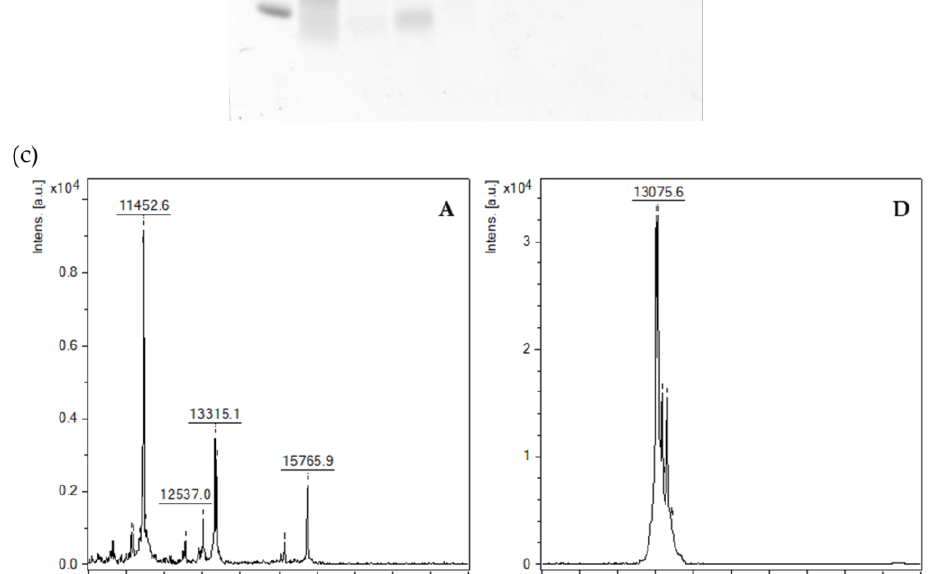
Figure 4. HPLC fractionation ( a ), SDS-PAGE ( b ) and MALDI TOF MS ( c ) of extracted ATIs from Julius .